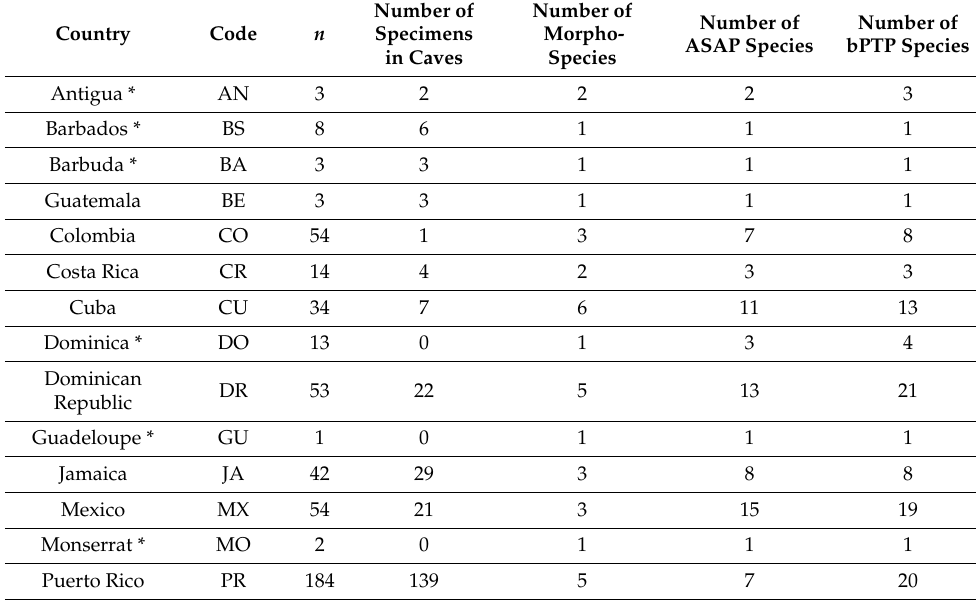
Table 1. Samples, number of specimens per country ( n ), sampled from caves, and morphological, ASAP and Poisson tree processes (PTP—-a phylogenetic tree-based method) species per country. *: Lesser